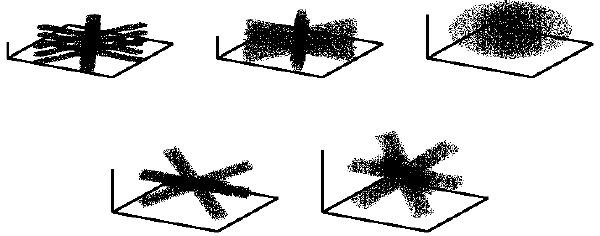
Figure 1. Discrete dipole models, clockwise from upper left: sector plate, SPp; six-branched planar rosette, B6pf; ellipsoid, Ep; eight- branched rosette with 0.5 aspect ratio, B8pr-30; eight-branched rosette with 0.7 aspect ratio, B8pr-45, as taken from Wood et al. (2015).